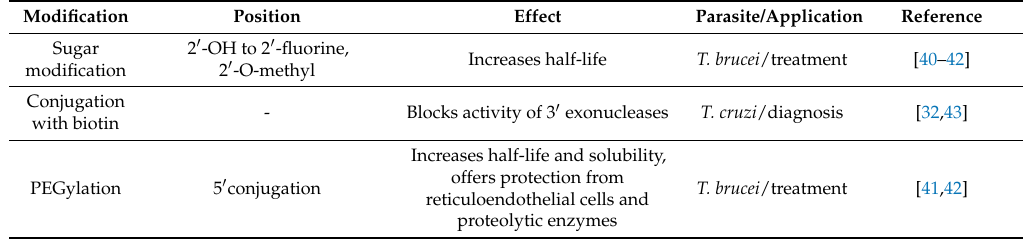
Table 2. Modifications of parasite-specific aptamers for diagnosis and